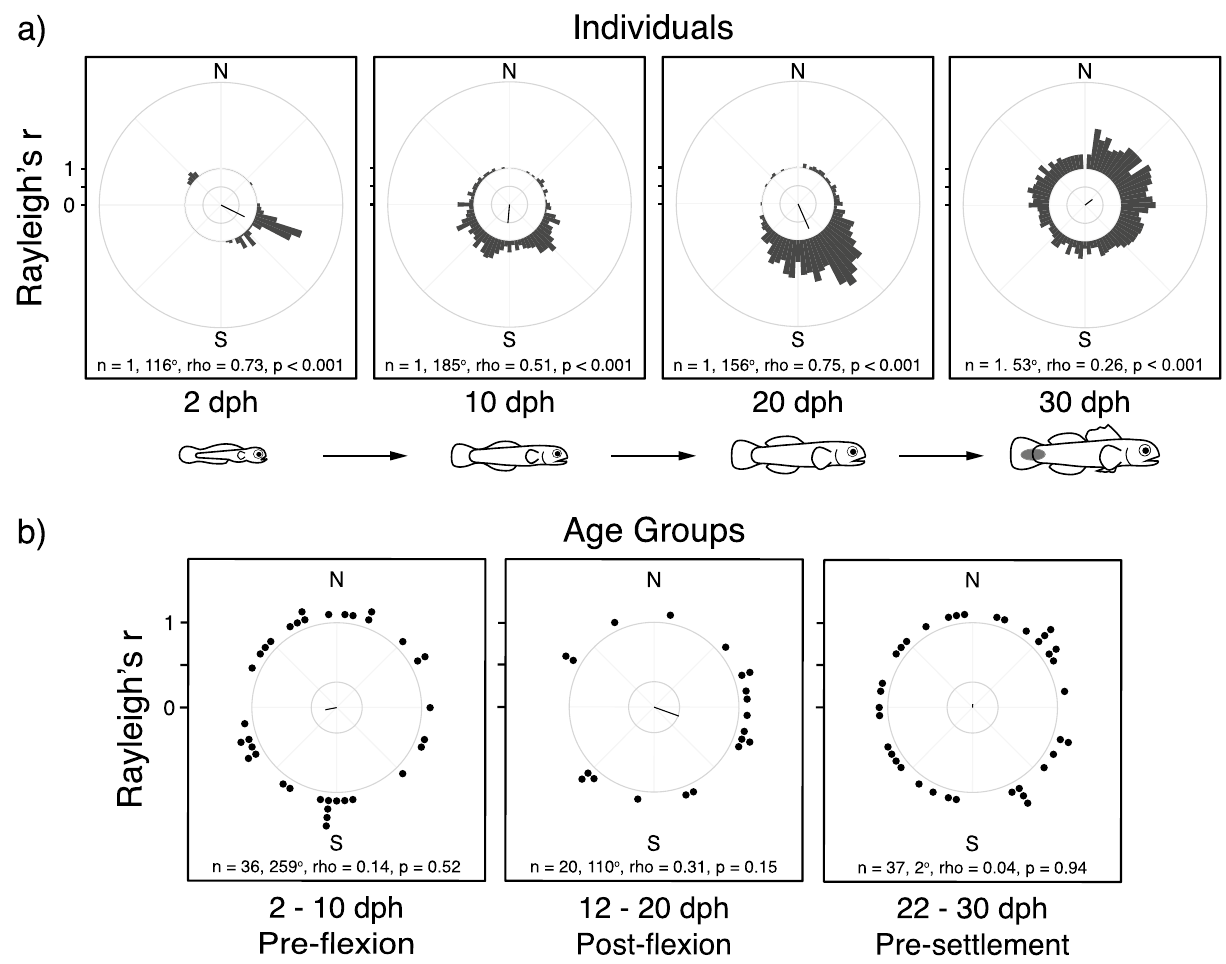
Figure 4. Ontogeny of orientation behavior towards a cardinal direction in lab-reared E. lori larvae deployed in situ in the DISC. ( a ) Randomly selected orientation plots for an individual larva at ages 2, 10, 20, and 30 days post-hatch (dph): grey bars indicate the frequency that a larva’s position was recorded within a 5° bin, and lines from the origin indicate the larva’s mean bearing. ( b ) Orientation plots comparing the mean bearing among larvae binned in three equal age groups: dots indicate the mean bearings of individual larvae, and lines from the origin indicate the mean bearing and rho-value among larvae in each age Once larvae are able to detect and interpret sensory cues, what orientation strategies do they use to reach a suitable settlement habitat? Larvae will have the greatest influence on their dispersal trajectory if they swim directionally 73 starting early during the larval phase 22 . Thus, one needs to consider what larvae are swimming toward. Directional swimming behavior is expected to enhance survival by reducing the probability that larvae are advected away from potential settlement habitat 21,22 . To achieve this, larvae could adopt one or more orienta- tion strategies that vary in complexity (Fig. 5). The simplest scenario is a single strategy, in which all larvae have the ability to swim along a common, constant bearing (i.e., orientation; Fig. 5: H 1 ). For example, if E. lori larvae develop in the water column offshore from the Belizean Barrier Reef and swim to the west, they would move toward reef habitat regardless of their starting position and could then seek out their preferred sponge hosts 37 . Alternatively, a more complex condition-dependent orientation strategy may be used where the optimal bearing of a larva changes depending on its overall ontogenetic stage, the structure and function of one or more sensory systems, or its physiological state (Fig. 5: H 2 ). For example, swimming to the east early in the larval phase may allow larvae to encounter higher densities of planktonic prey and escape the threat of planktivorous reef-based predators. However, later during the larval phase, swimming to the west may increase the probability of locating appropriate settlement habitat. A natal reef represents high quality settlement habitat that has resources suitable for the survival and repro- duction of post-settlement fishes. Assuming that the habitat is not saturated and the chance of inbreeding is low, larvae that adopt a context-dependent strategy and swim toward their natal reef may increase their potential for reaching settlement habitat that can ultimately maximize their fitness (e.g., true navigation toward their natal reef; Fig. 5: H 3 ). Another context-dependent strategy would be for larvae to swim toward the nearest reef, which may increase the potential for reaching suitable settlement habitat if a larva had been advected away from its natal reef (e.g., true navigation toward the nearest reef).